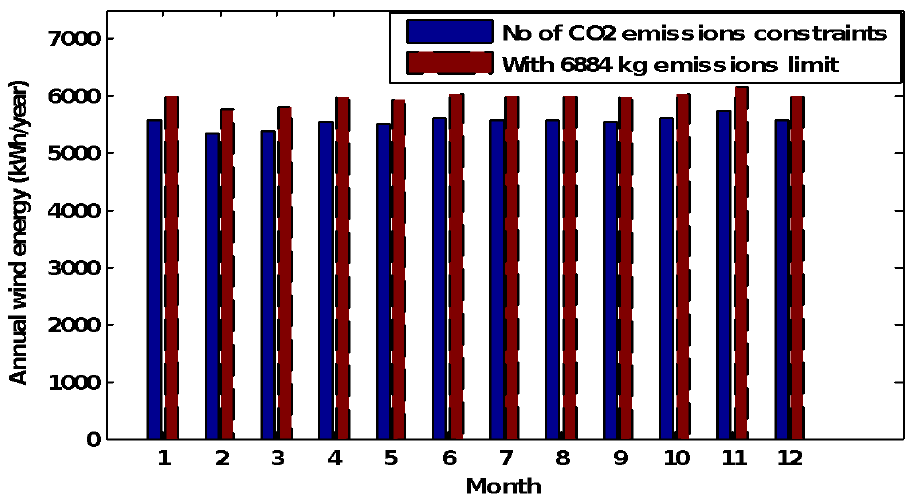
Figure 5. Monthly wind energy in a year with and without constraints using PSO